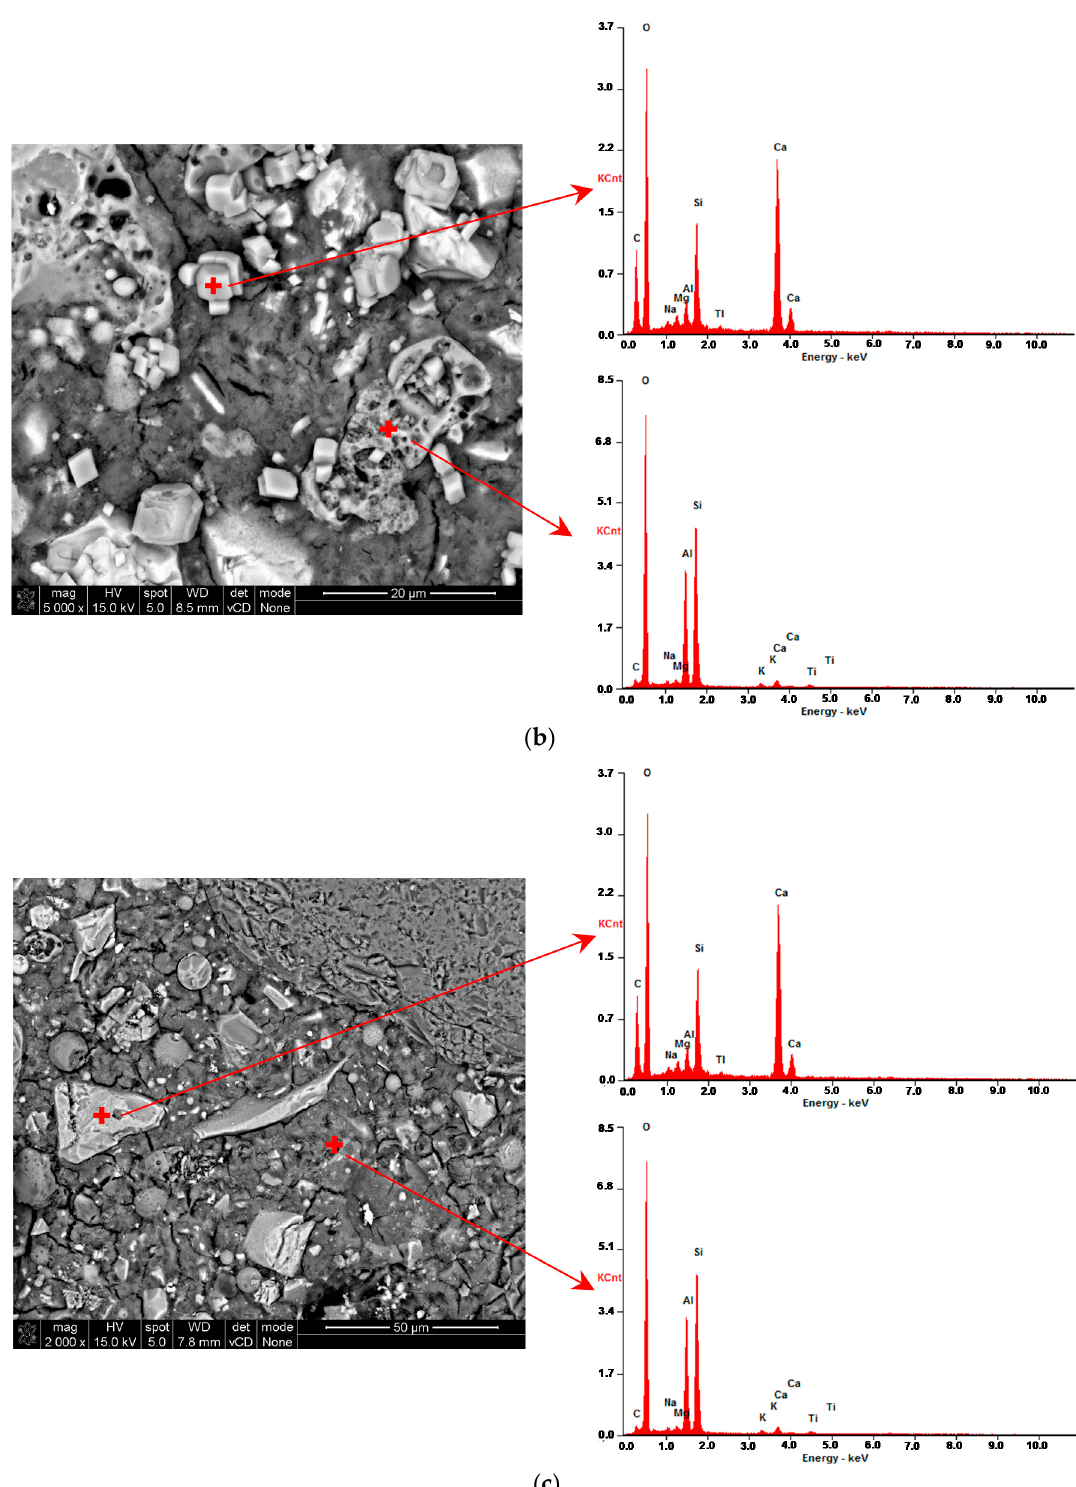
Figure 8. EDS analysis results at indicated points of ( a ) C55_SFA15_SF3, ( b ) C100_SFA15_SF3, and ( c ) C100_SFA30_SF3 samples.